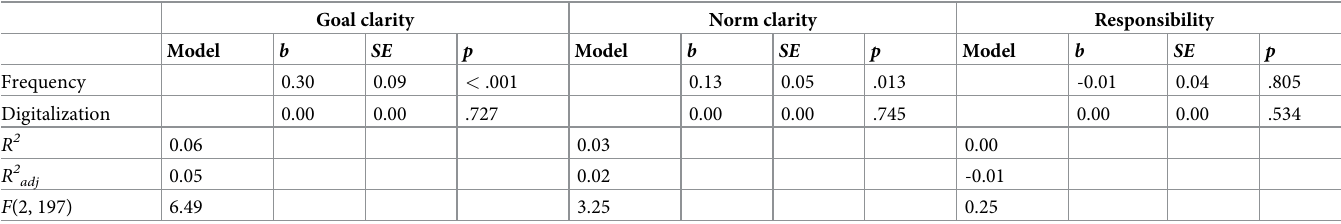
Table 2. Multiple regression analyses of Study 1 ( N =